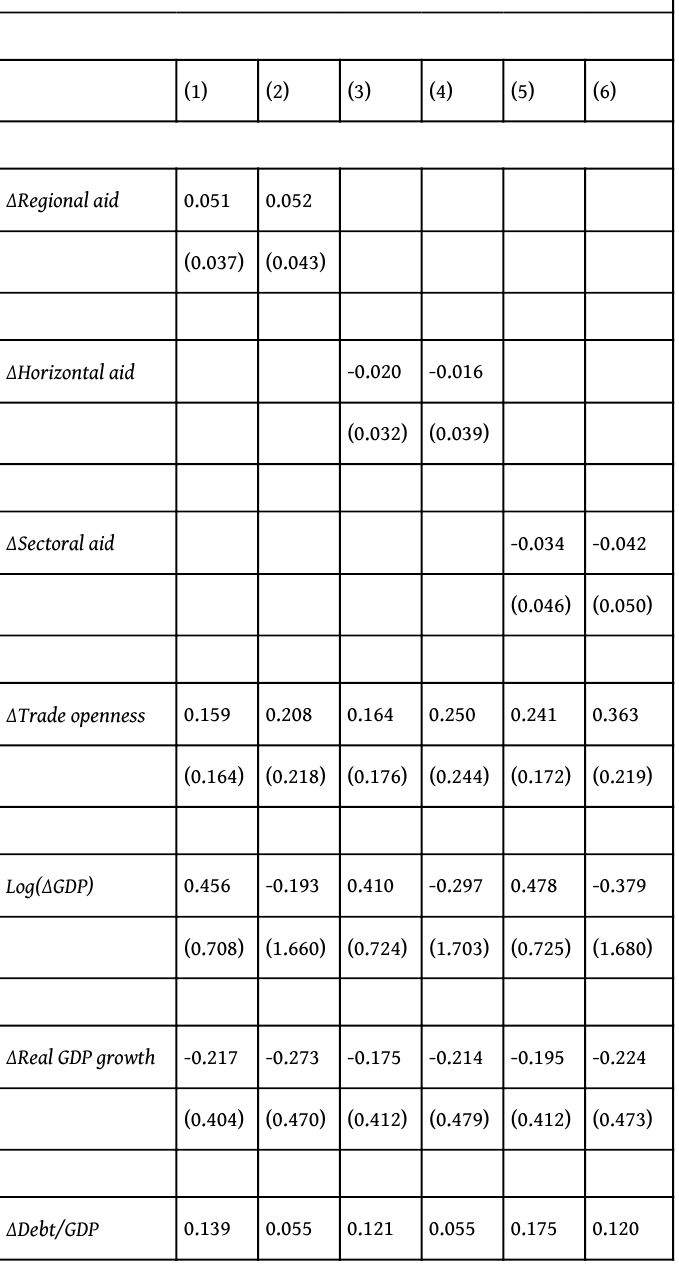
Table 3: The effect of post-SAM aid allocations on FDI openness (2013-18)